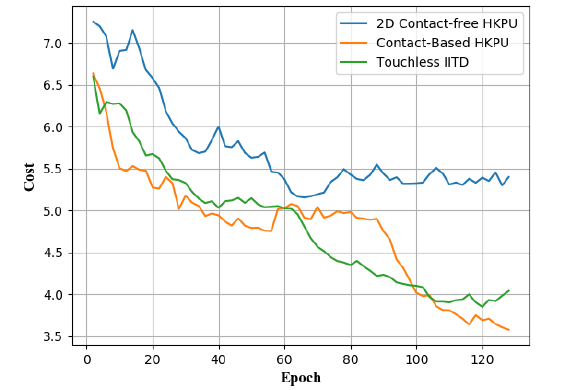
Figure 11. Fine-tuning cost versus epoch in Feature Extraction Module for contact-based Hong